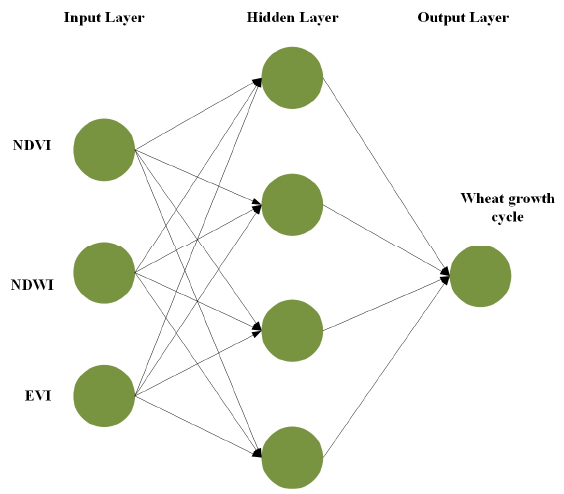
Figure 4. BP neural network structure and topology of the computational propagation process.